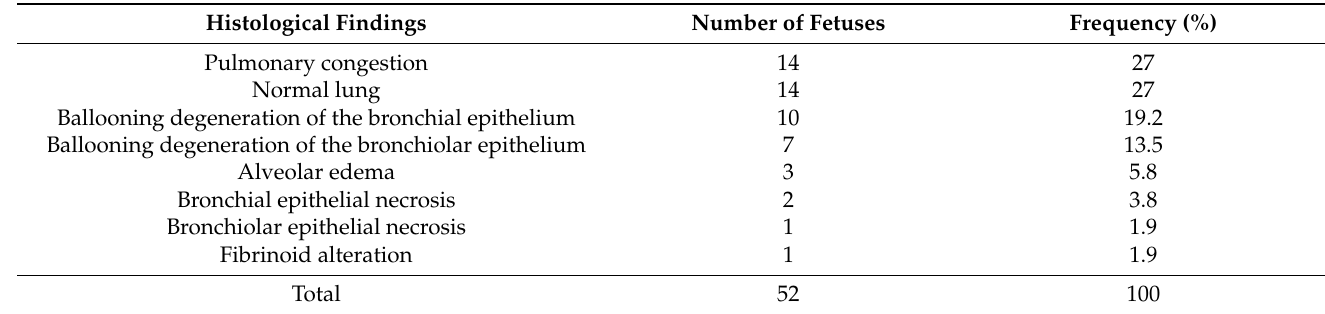
Table 3. Histological findings observed within the patterns of pulmonary lesions observed in 37